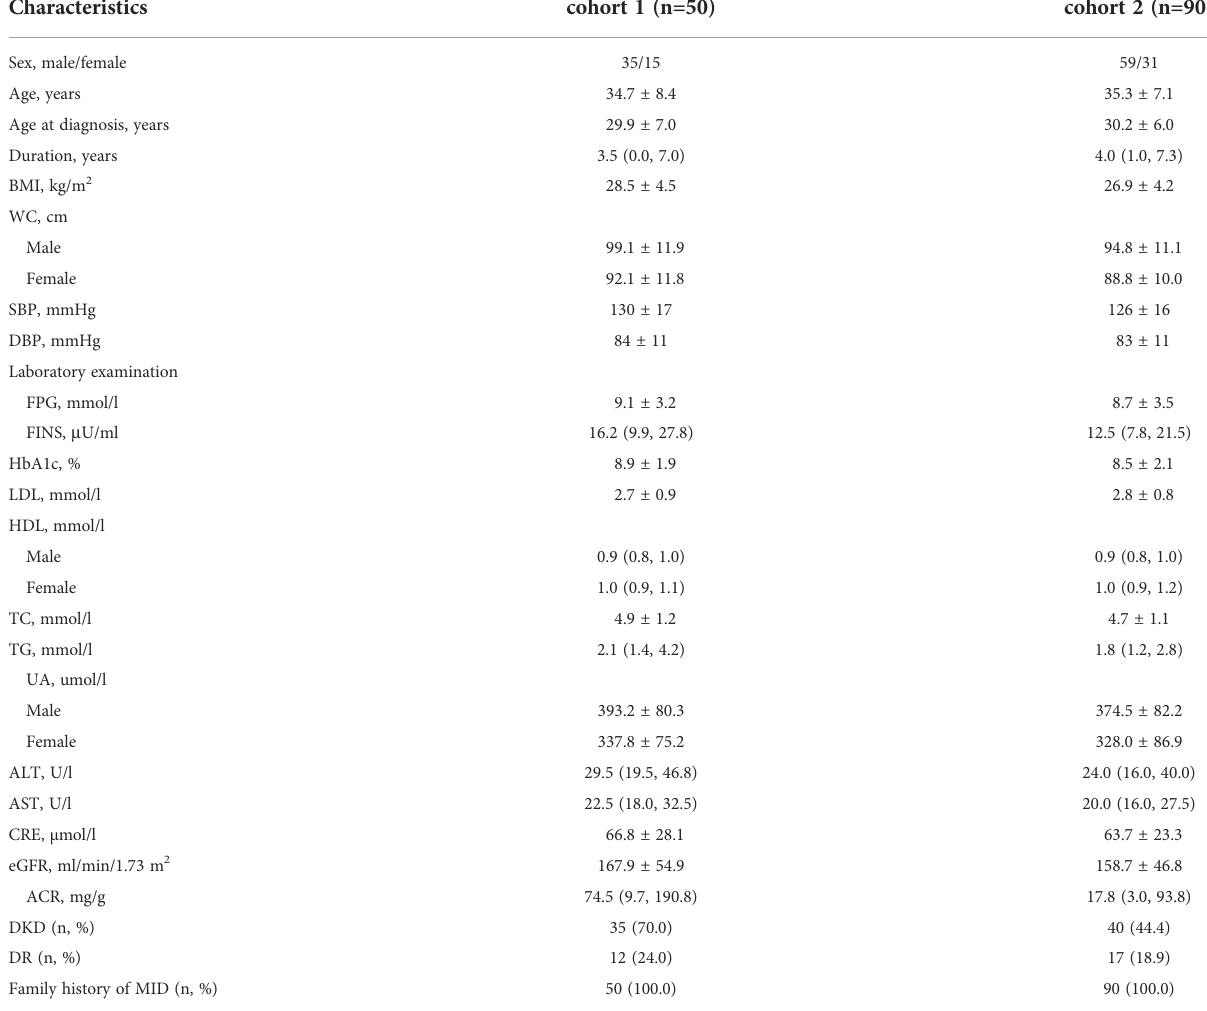
TABLE 1 The clinical characteristics of the patients from cohort 1 and cohort 2.